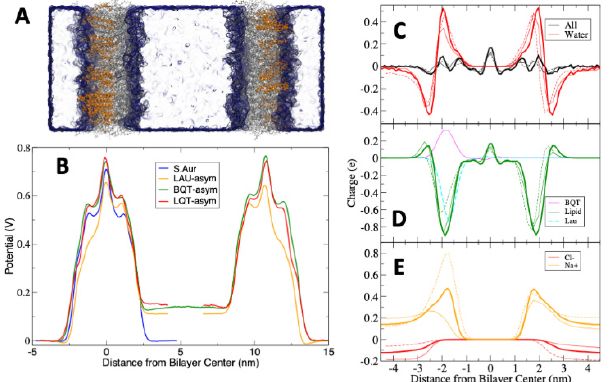
Figure 6. Electrostatic potentials across the S. aureus membranes with BQT and LAU in either one or both. For the asymmetric membrane, we used a double bilayer (see methods), ensuring the potential is equal at the box edge. ( A ) Snapshot illustrating the double bilayer, with the BQT surfactant highlighted as orange lines. The other lipids are grey lines, and water a blue surface. ( B ) Electrostatic potential profiles across the asymmetric double bilayers. For LQT and LAU, we cut the curve and shifted the right side to match the BQT bilayer for easier comparison. ( C – E ) Charge distributions for each system, S. aureus (thick lines), BQT (thin lines), and LAU (dashed lines).